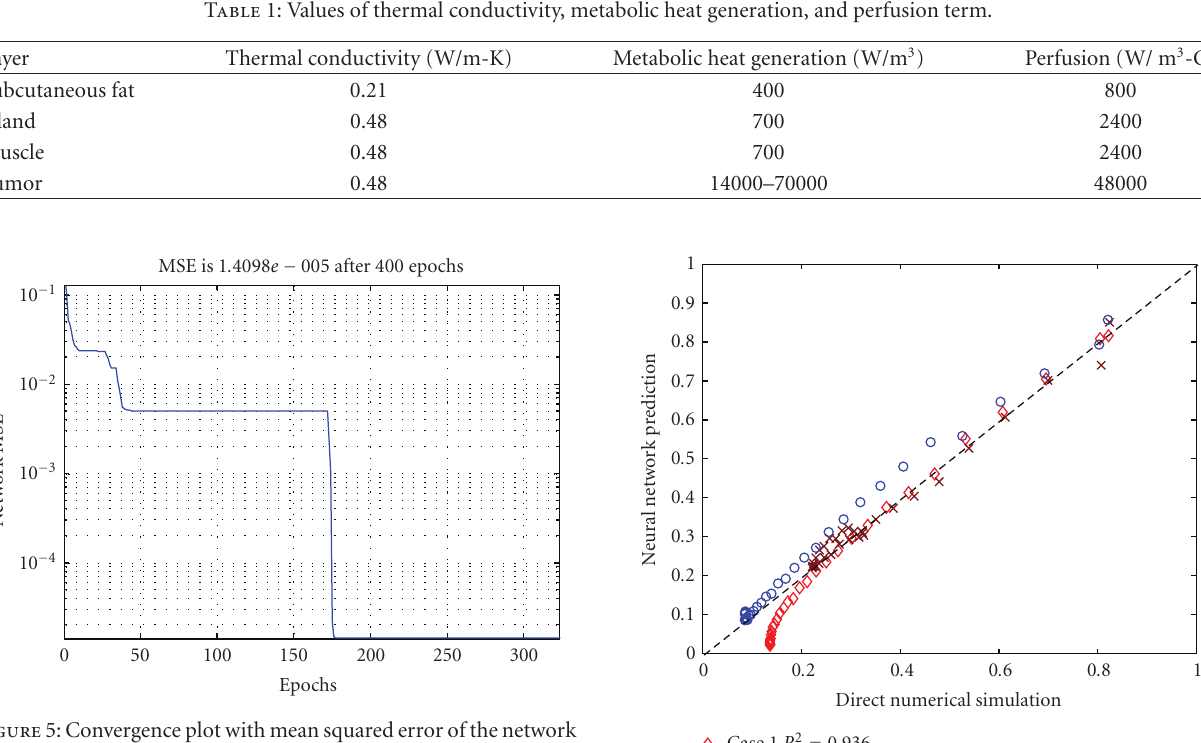
Figure 5: Convergence plot with mean squared error of the network output during training.